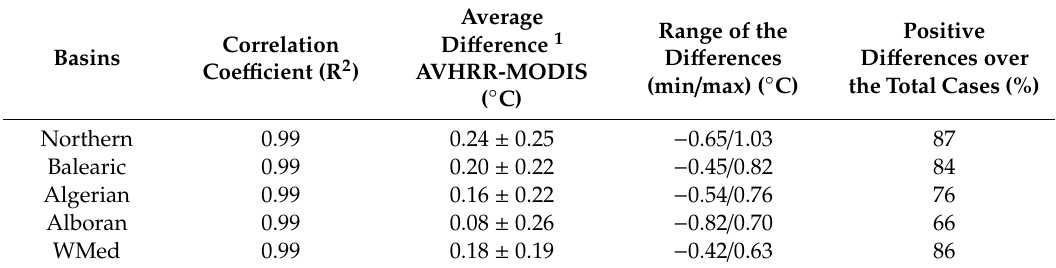
Figure 4. Correlation between monthly SST obtained from AVHRR and MODIS sensors in different basins: ( a ) Western Mediterranean and ( b ) Northern, Balearic, Algerian, and Alboran sub-basins. Table 1. Comparison of the monthly mean SST values obtained in each basin from AVHRR and MODIS data for the period 2000–2009.